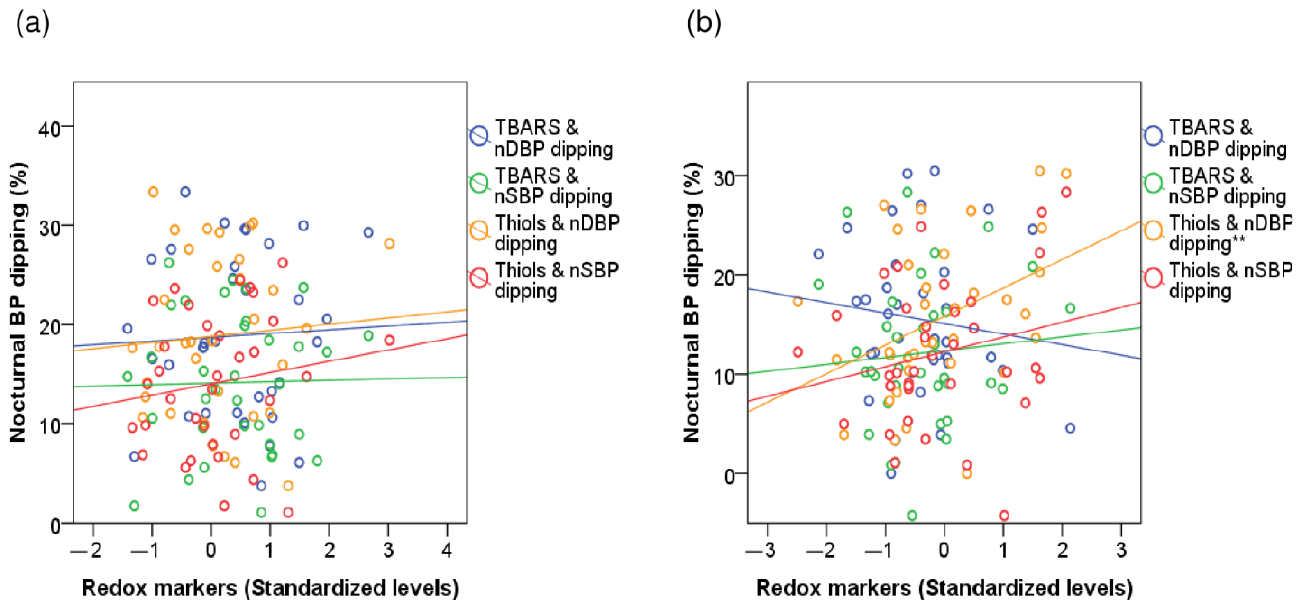
7 of 12 Figure 1. Comparison of redox markers levels and 24-h ABPM indices between patients with morning and bedtime use of RAAS blockers. (a) Hypertensive patients. (b) Dipper hypertensive patients. (c) Non-dipper hypertensive patients. Box-and-whisker diagram. The horizontal line of the box represents the median, and the upper and lower box edges represent the 3rd and 1st quartiles (Q), respectively. The edges of the upper and lower whiskers represent the Q3 + 1.5 × interquartile range and Q1 − 1.5 × interquartile range, respectively. Data represented by diamonds are outliers. The point cloud represents the distribution of the sample values. The non-standardized results expressed as median and interquartile range are shown in Tables 2 and 3. TBARS levels, reduced thiol concentrations, and blood pressure indices were measured in nmol/mg Lp, mmol/L, and mmHg, respectively. Terms: 24-h ABPM–Twenty-four-hour ambulatory blood pressure monitoring; RAAS–Renin-angiotensin-aldosterone system; SBP–Systolic blood pressure; 24-hSBP–Average SBP over 24 h; dSBP–Average SBP during the day; nSBP–Average SBP during the night; DBP–Diastolic blood pressure; 24-hDBP–Average diastolic BP over 24 h; dDBP–Average DBP during the day;